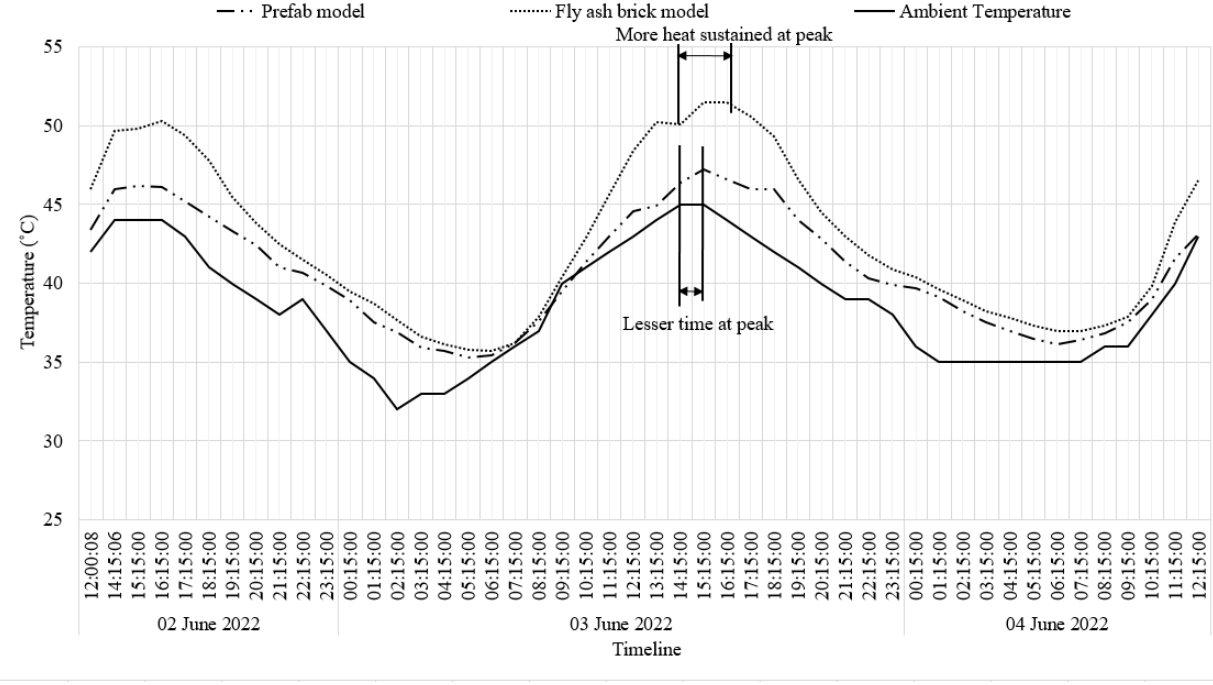
Figure 13. Thermal inertia of developed models.